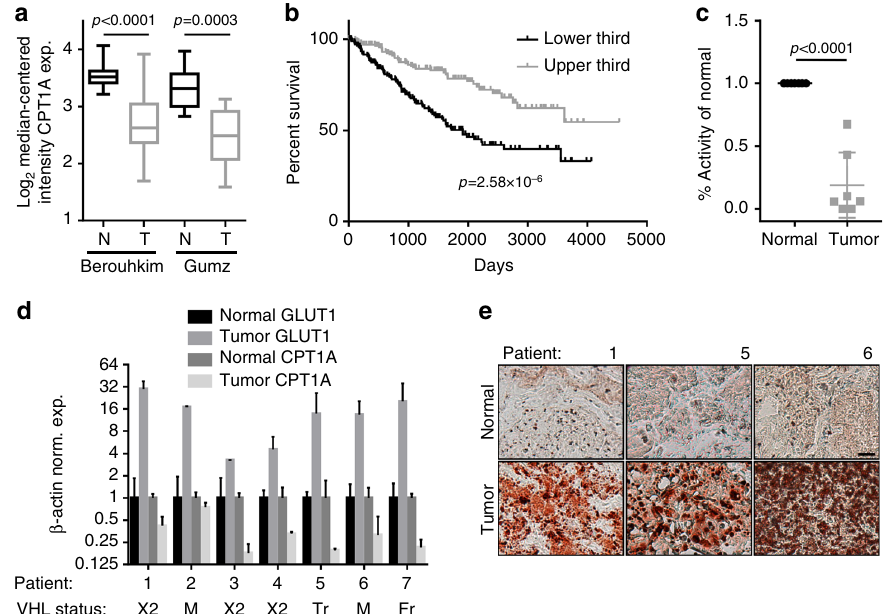
Fig. 8 CPT1A expression and activity are reduced in ccRCC tumor tissue. a Box and whisker plots of Oncomine data demonstrating decreased expression of CPT1A mRNA in two studies. Data are depicted as Log CPT1A mRNA in normal (N) versus tumor 2 transformed, median-centered intensity expression of (T). In the Berouhkim data set, CPT1A is repressed 1.82-fold; in the Gumz data set, CPT1A is repressed 1.79-fold. b Kaplan – Meier survival plot of patients with upper and lower third expression of CPT1A from the TCGA ( n = 172 for each group). c Activity measurements of CPT1 in mitochondria isolated from clear cell renal carcinoma tumors versus adjacent normal tissues in seven patients. Data are presented as % change compared to the activity in matched normal tissues. d Normalized expression of GLUT1 and CPT1A in tumor and normal tissues of ccRCC patient samples from c , as well as VHL status indicated below (×2 = exon 2 deletion, M = mutation, Tr = truncation, Fr = frame shift). e Representative Oil Red O staining of three patient tumor samples and normal kidneys, as indicated. Bar = 20 μ m. p values of two-tailed Student ’ s t tests are displayed ( a , c ) and Log-rank test ( b